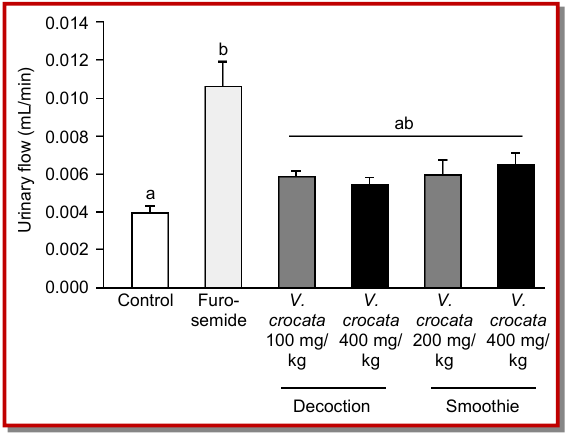
Figure 1: Urinary flow. Data are mean ± SEM., n = 6, a p<0.05 compared to control group, b p<0.05 compared to